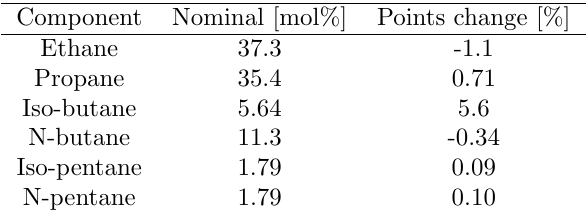
Table 1: The feed composition change in the T100 feed at t = 360